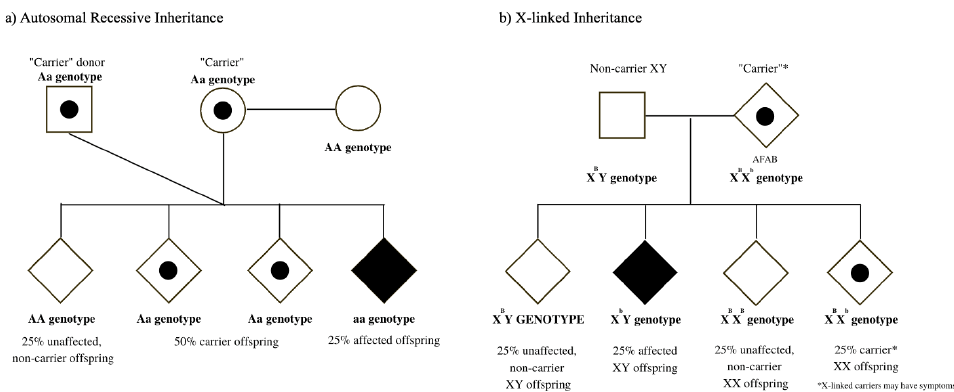
Figure 1. ( a ) Autosomal recessive inheritance pattern: same-sex couple conceiving using a sperm donor ( b ) X-linked inheritance pattern: non-binary individual AFAB (assigned female at birth) who is a manifesting